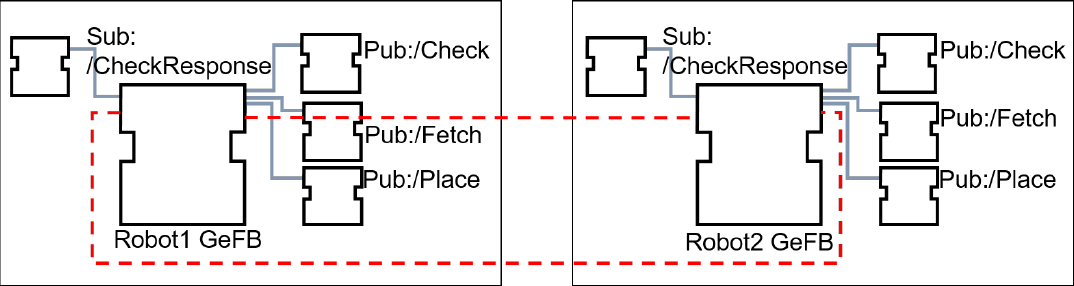
Figure 6. System schematic diagram of two robot collaborative assembly system. More details see video at